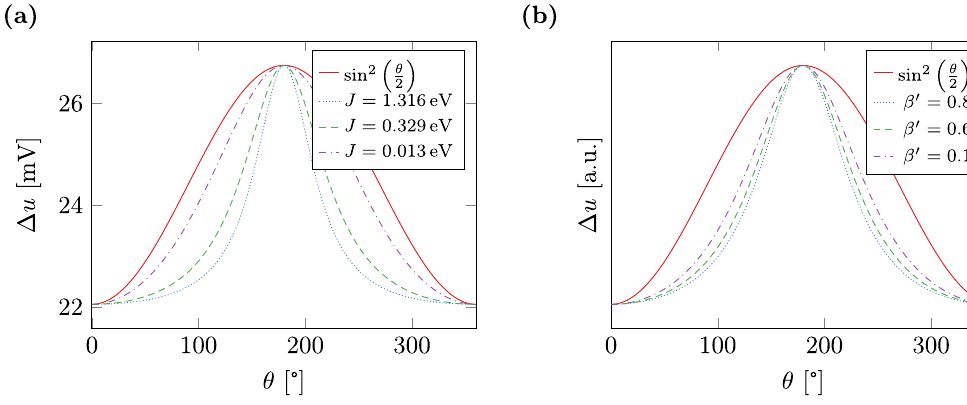
Figure 3. Potential difference Δ u between top and bottom contact required to generate an average current density of j e = 10 12 A/m 2 depending on the tilting angle of the magnetization in the free and fixed layer of a magnetic multilayer structure. ( a ) Variation of J for β ′ = 0.8 ( b ) variation of β ′ for J = 0.263 eV. The results are renormalized in order to facilitate the comparison to the sine parameterization.